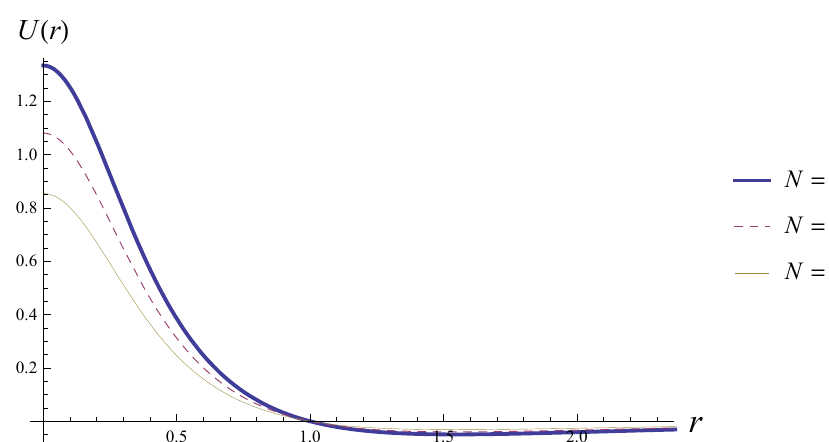
Figure 5. The potential U ( r ) in the Einstein frame for H = − 1/2 (phantom sector) and N = 1, 0.9, 0.8.